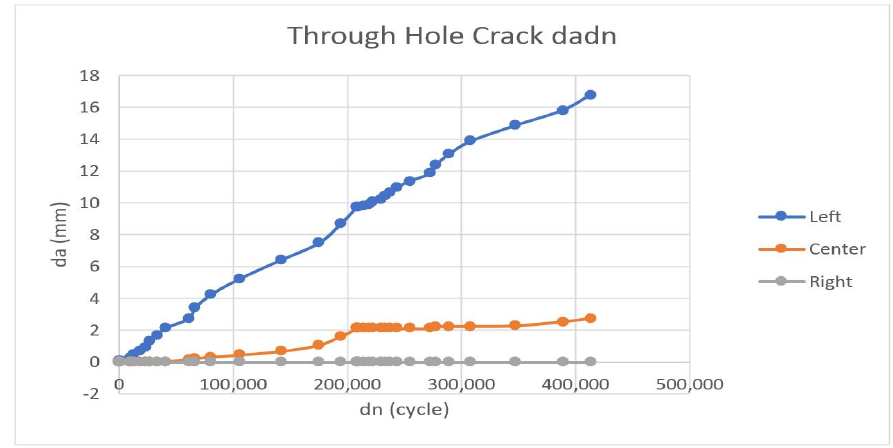
Figure 14. Cycle vs. the sum of d a for through hole crack.